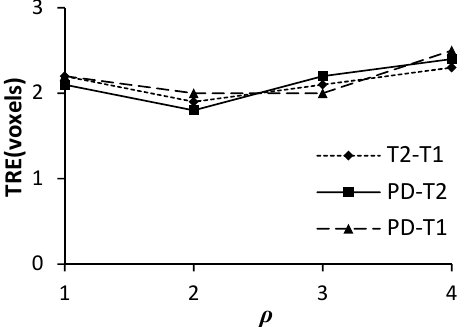
Figure 5. The target registration error (TRE) with different ρ values.